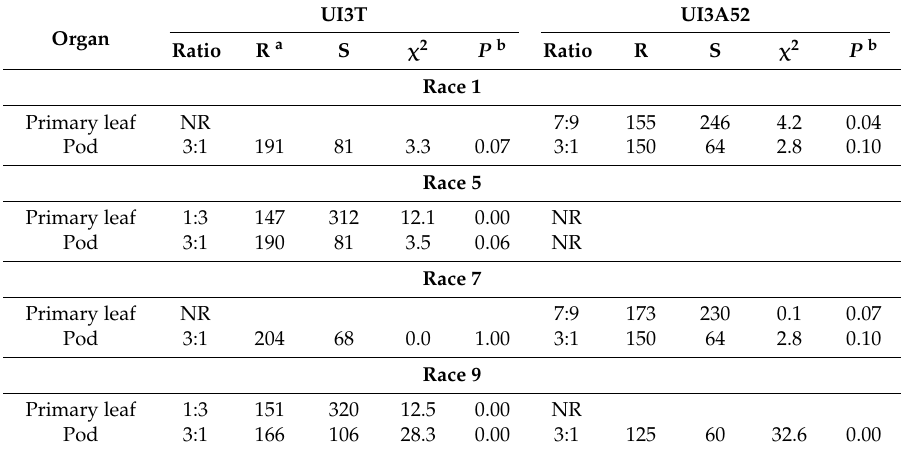
Table 3. Observed segregation of the F 2 UI3T and UI3A52 populations for a qualitative halo blight reaction to races 1, 5, 7 and 9 in primary leaf and pod